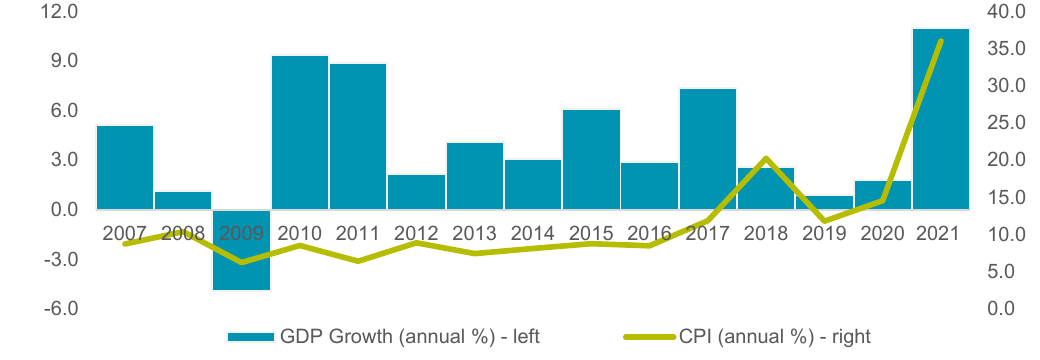
Figure 2 GDP and CPI (inflation) Growth, TURKSTAT,